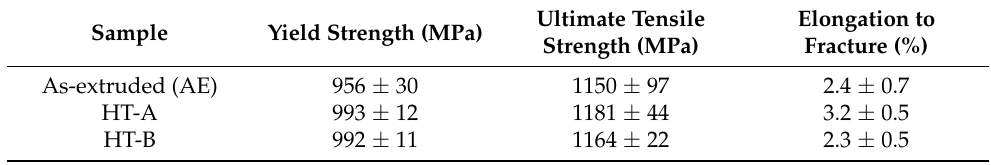
Table 3. Summary of average tensile properties obtained for as-extruded and annealed Ti-6Al-4V alloy prepared from blended powders using thermomechanical powder consolidation (TPC) route.